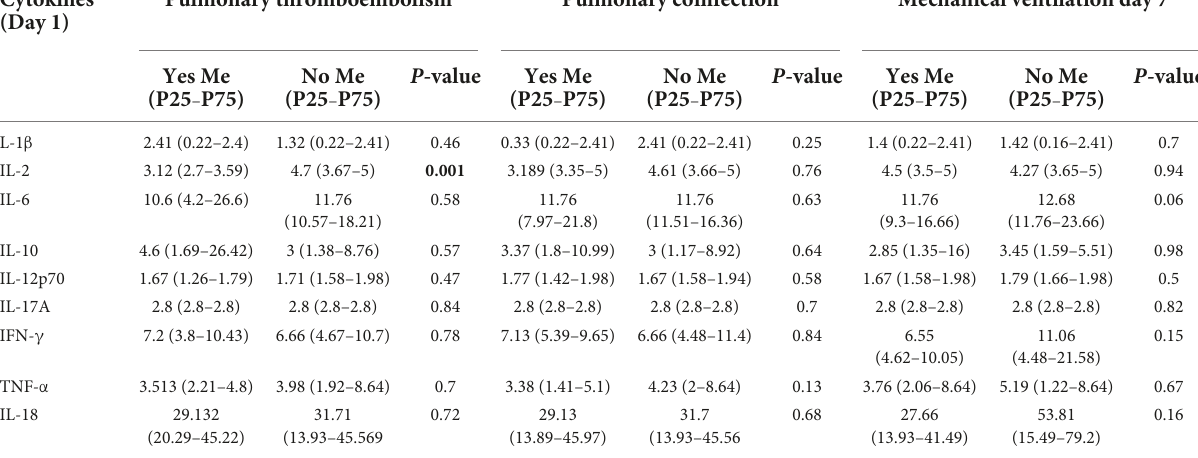
TABLE 5 Cytokine concentration and correlation with pulmonary coinfection, mechanical ventilation on day 7 and pulmonary thromboembolism. Cytokines (Day